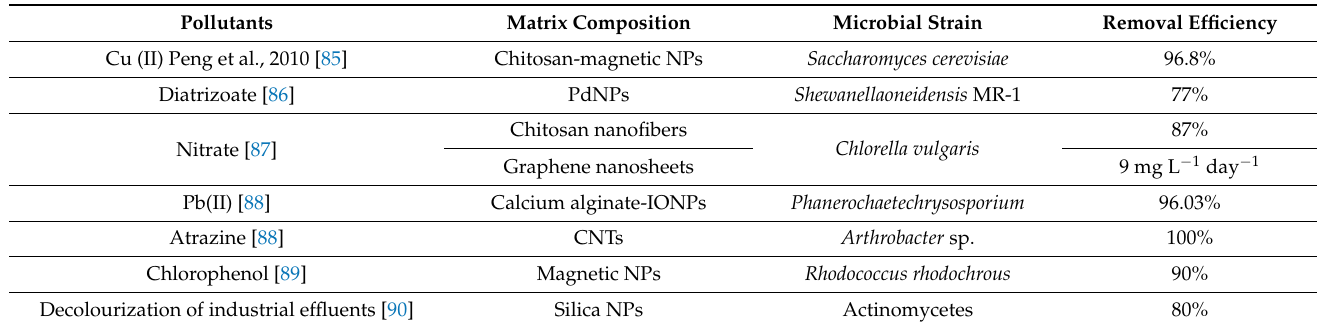
Table 3. Substrates for the Immobilization of non-absorbent and effective removal of pollutants. Pollutants Matrix